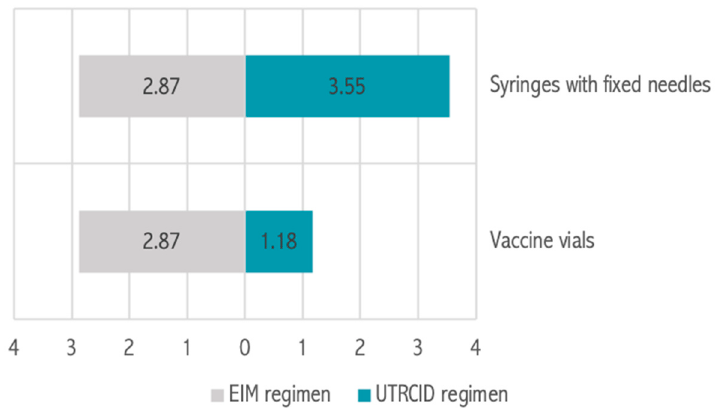
Figure 4. Items consumed per person for rabies vaccination via the Essen intramuscular (EIM) regimen and updated Thai Red Cross intradermal (UTRCID) regimen. Values are expressed as n .